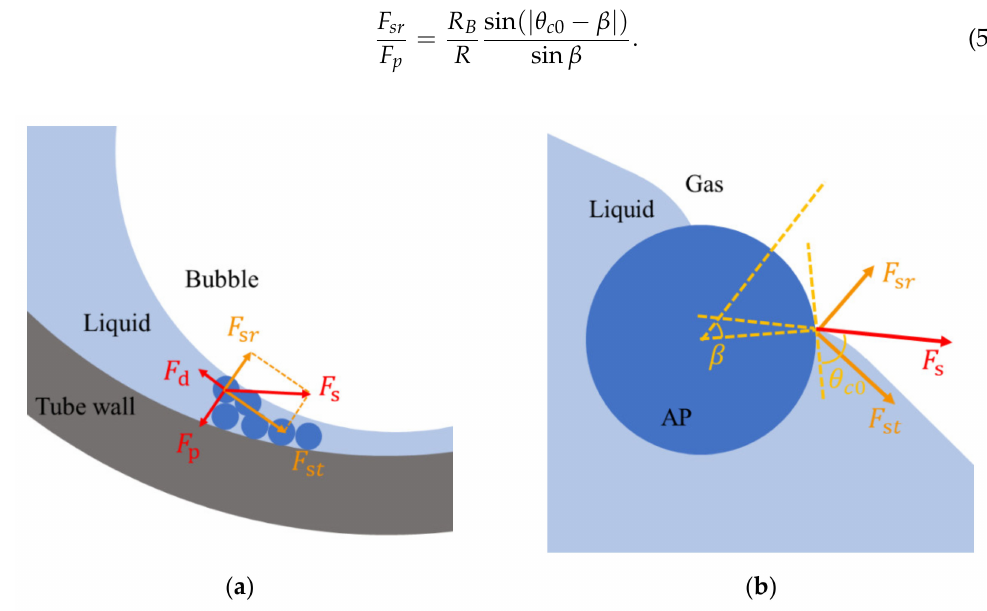
Figure 8. Schematic figure of the forces on an AP at the bubble surface. ( a ) The pressure force and the surface tension force balance in the radial direction; ( b ) Diagram of the surface tension